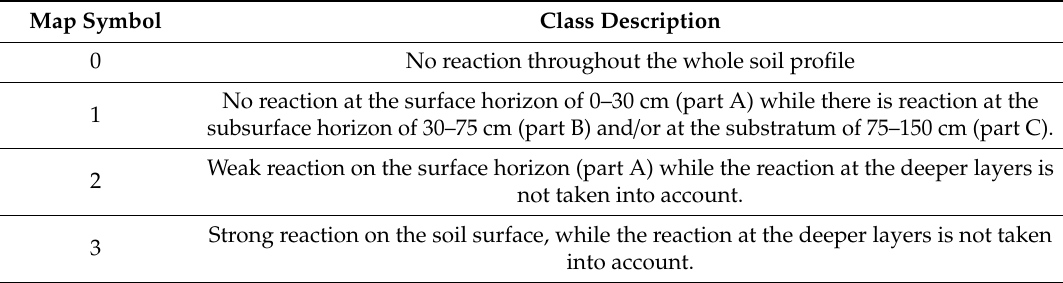
Table A5. Classes of inorganic carbonates with the corresponding